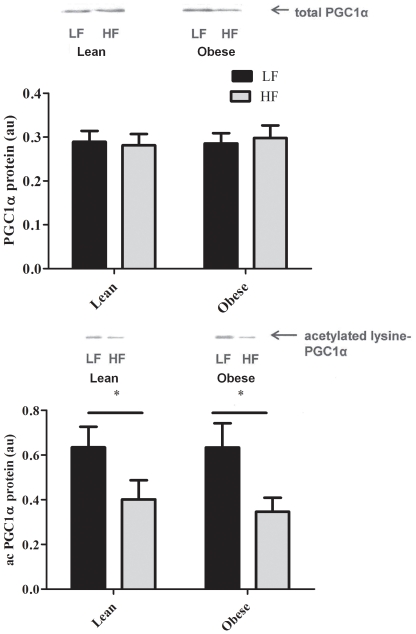
Mean (± SE) total (Top) and acetylated (Bottom) PGC1α protein (Bottom) during LF (black bars) and HF (grey bars) in LN (N = 5) and OB (N = 6).Representative blots are show above the graphs. * LF significantly different from HF (P<0.05).